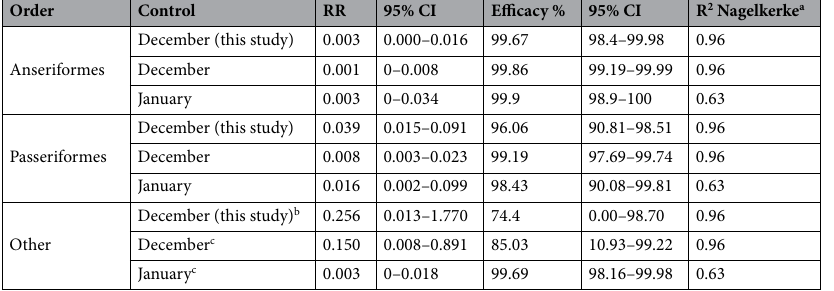
Table 3. Relative risk ratios (RR) and efficacy of the laser to reduce wild birds visits estimated by taxonomic Order. a These measures indicate the overall performance of the generalized linear models (negative binomial distributions) used to quantify the RR and Efficacy; the three R 2 values are given for each of three models (Number of birds ~ wild bird Order + Laser_present:Order) fitted for each of the scenarios: (1) this study, (2) December previous study as control, (3) January previous study as control. b The Orders Falconiformes, Gruiformes and Strigiformes were grouped as “Others”. c The Orders Charadriiformes, Falconiformes, Gruiformes and Strigiformes were grouped as “Others”.